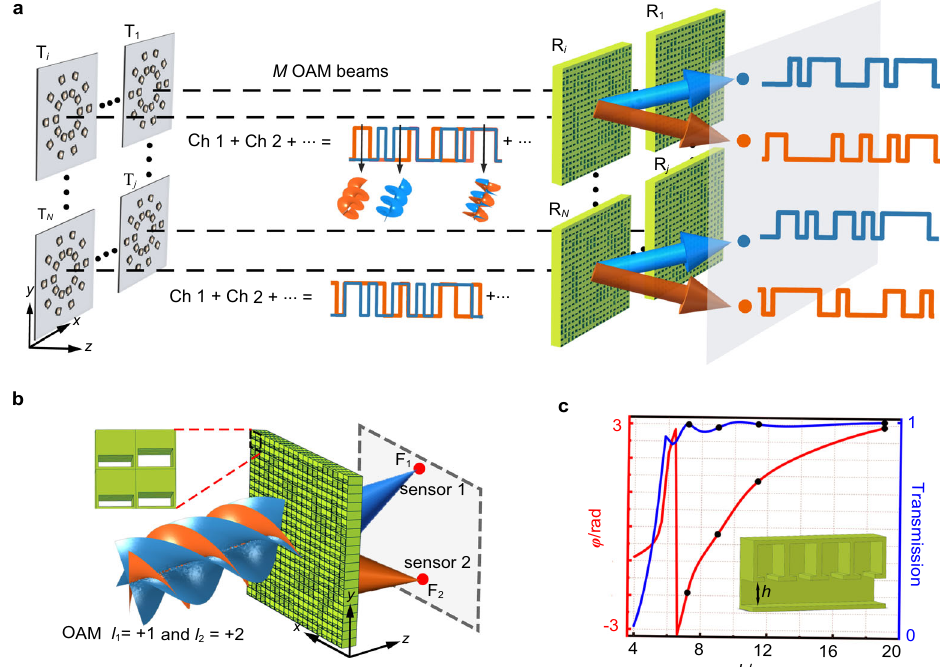
Fig. 1 | Schematic of free-space acoustic communication with high spatial information density by multi-path twisting of acoustic wave. a The designed communication system consists of N pairs of transmitting and receiving units with each transmitting unit containing M coaxial vortex beams with different orders, resulting in a total number of NM independent data channels. At the receiving terminal, real-time andpassive decoding ofthe transmittedinformationis realized by using N metamaterial-based demultiplexers with planar pro fi le and ultrathin